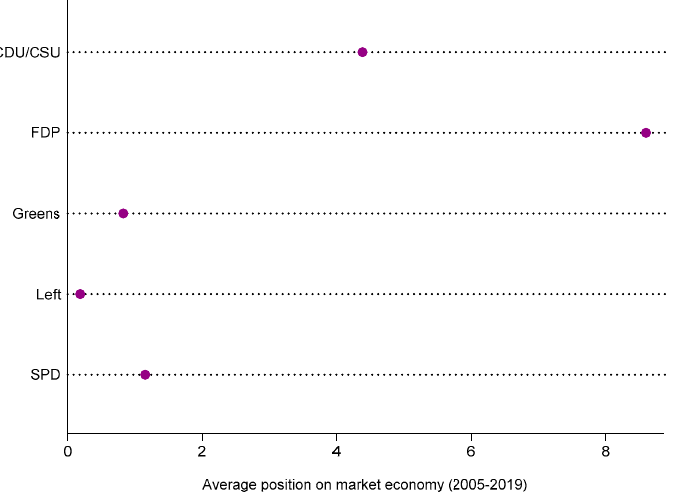
Figure 1. The average positions of German parties on the market economy, 2009–2017.